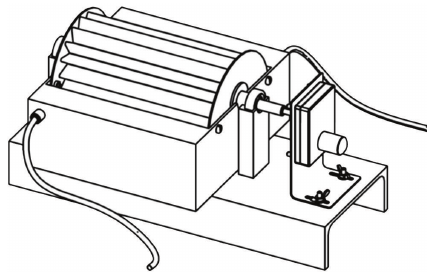
Figure 1: Photoreactor experimental apparatus.